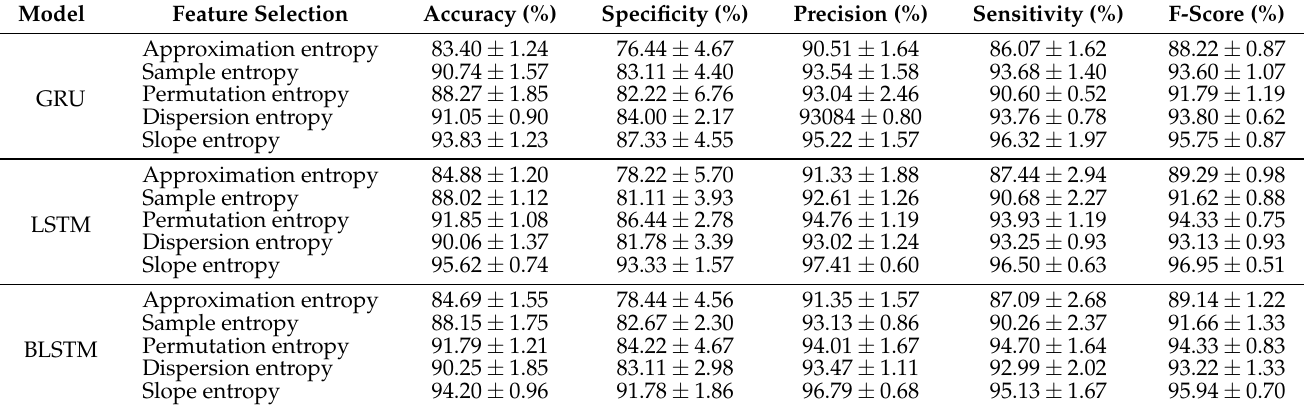
Table 7. The classification performance obtained for RNN classifiers for selected entropy features using the hold out CV approach for the BMAC vs. GMAC classification task.